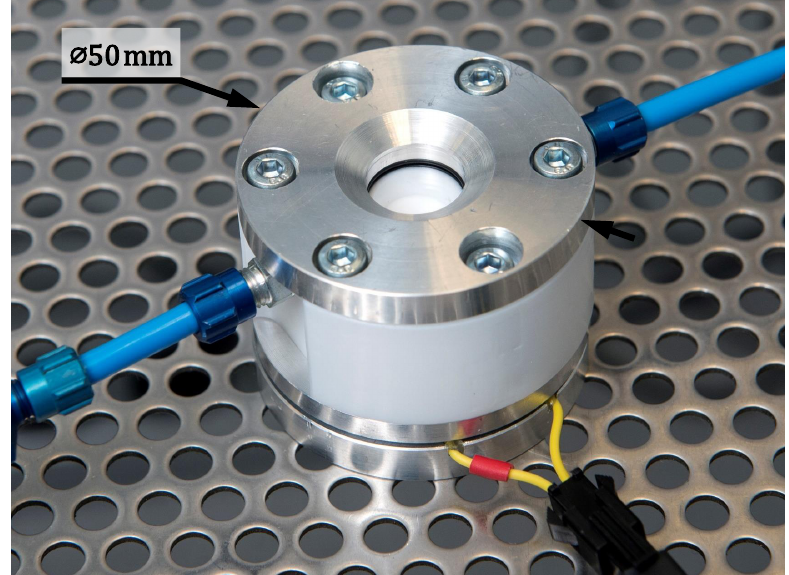
Figure 4. Setup after fabrication and assembly. The vacuum and liquid tubing can be connected using the blue connectors on each side of the setup. The electric wiring for the actuator is fed in through the base of the environment